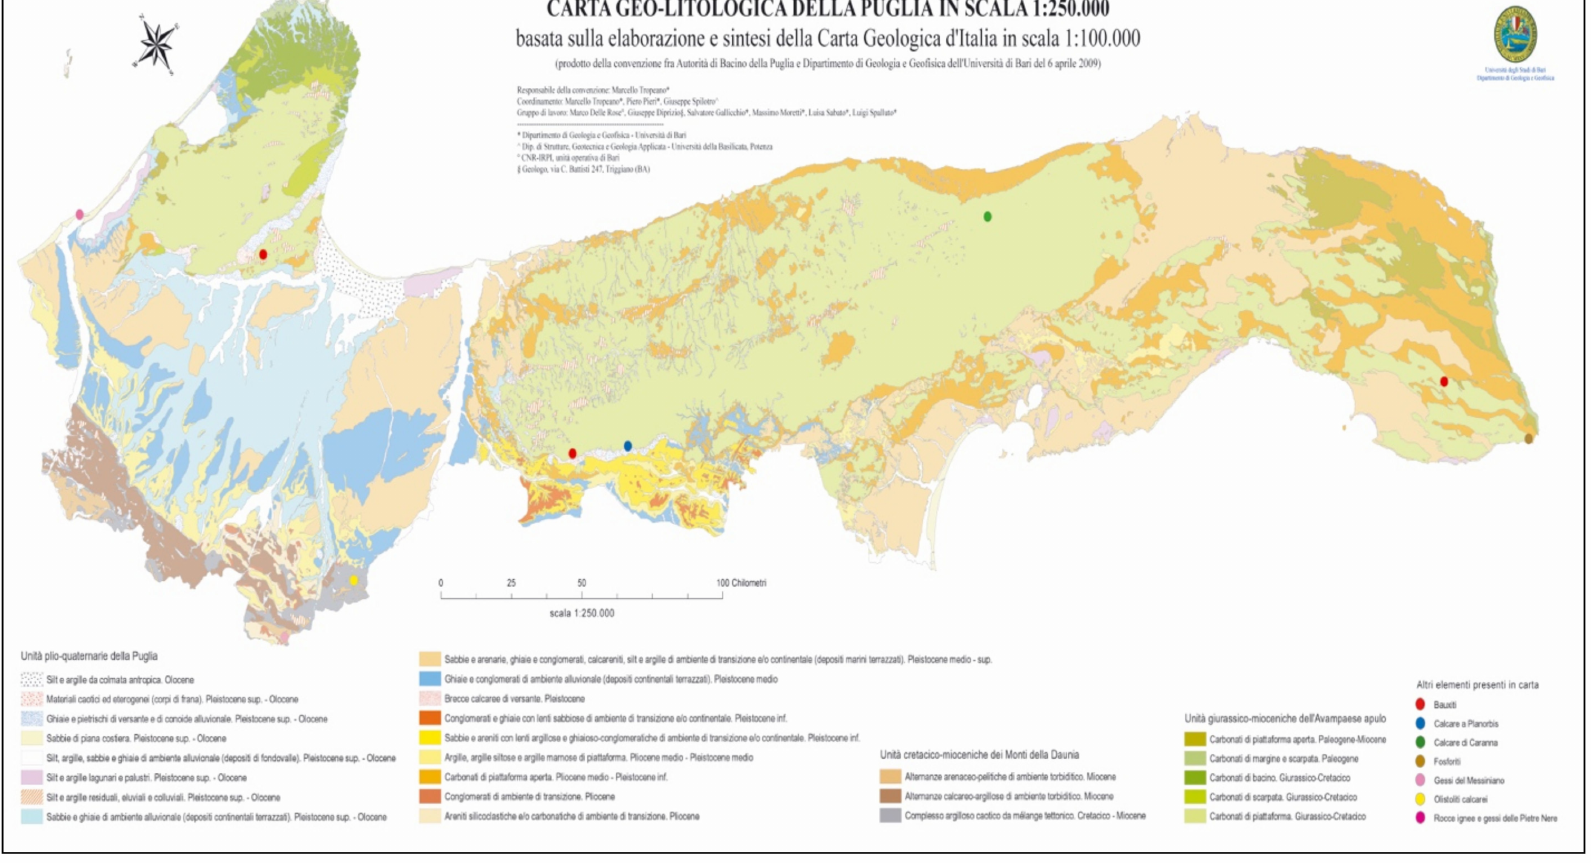
Figure 1. Geo-lithological map of Puglia, scale 1:250.000. Apulia in scale 1:250000 (produced by the agreement between the Apulia Basin Authority and the Department of Geology and Geophysics of the University of Bari on 6 April